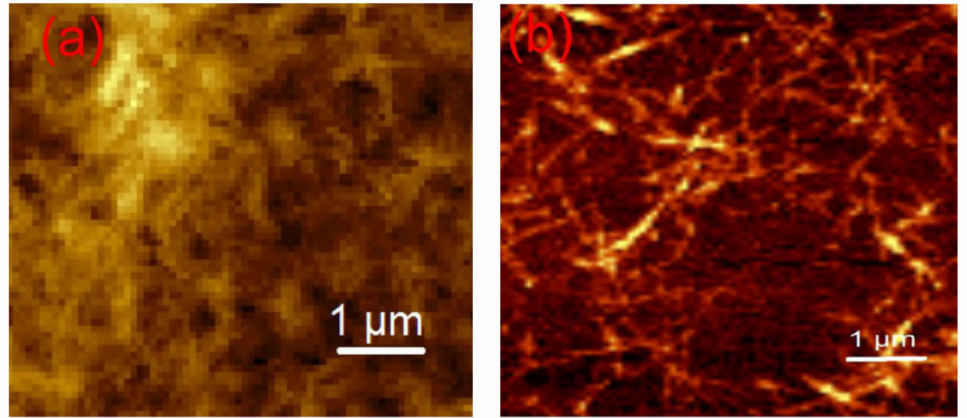
Figure 19. AFM of cellulose: ( a ) nanocrystals (CNC), ( b ) nanofibers (CNF). Reproduced with permis- sion from Macromol. Symp. , 380 ( 1 ), Balakrishnan et al., Cellulose Nanofiber vs. Nanocrystals From